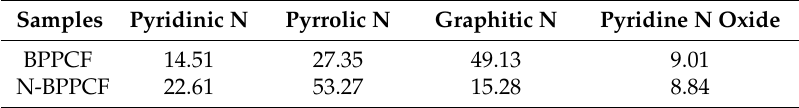
Table 3. Atomic ratio of various N species from deconvolution N 1s